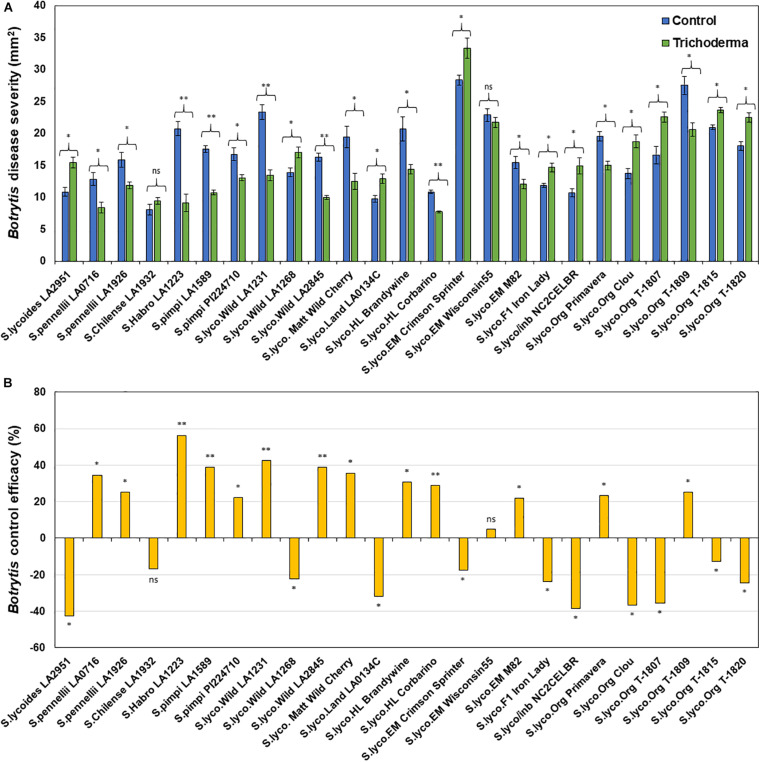
Effect of Trichoderma treatment on plant resistance against Botrytis cinerea in a diverse set of tomato genotypes (A). Graph (B) represents control efficacy of Trichoderma against B. cinerea in comparison with the control treatment. Asterisks indicate significant differences in disease severity in the Trichoderma-treated versus control plants using the Student’s t-test at a ∗P ≤ 0.05 and ∗∗P ≤ 0.01. Bars represent the standard error.